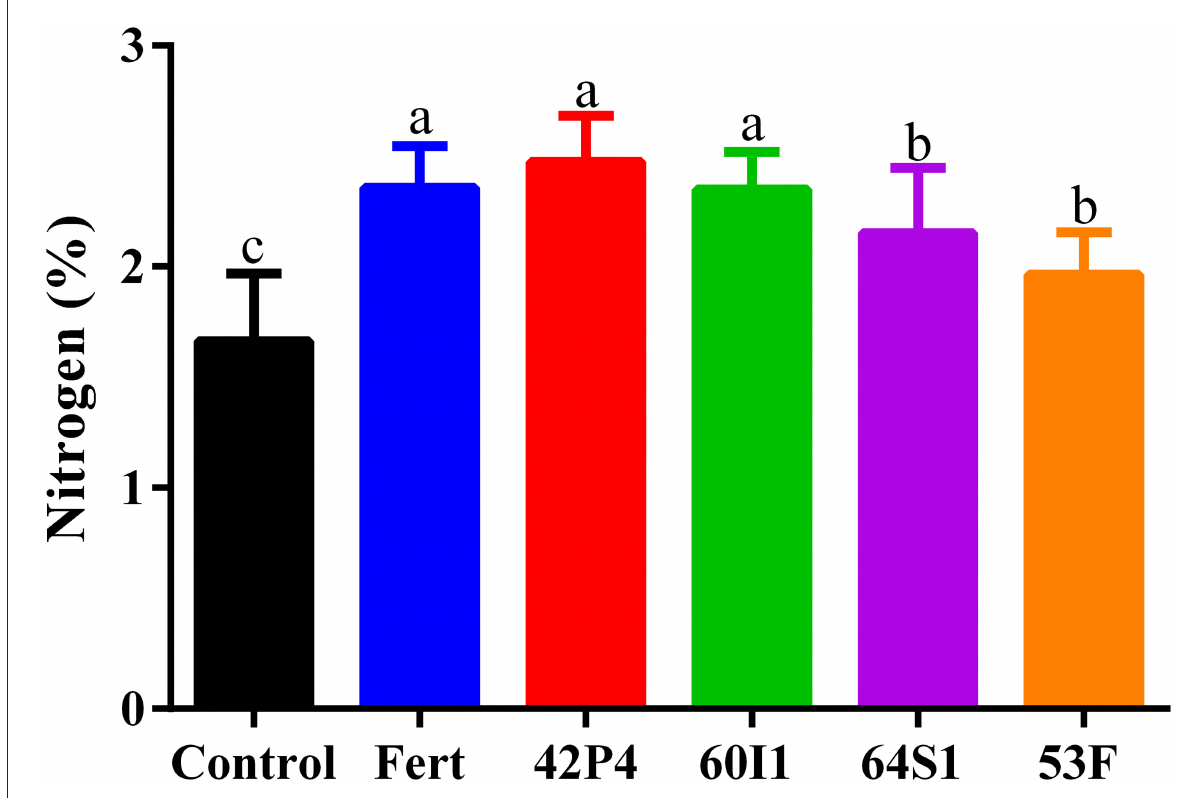
FIGURE3 Nitrogen content in leaves of pepper plants of 55 day-old after treatment with Fert: Fertilized; 42P4: Pseudomonas 42P4; 60I1: Cellulosimicrobium 60I1; 64S1: Enterobacter 64S1; 53F: Ochrobactrum 53F and Control (without bacteria). Data are presented as mean ± SEM of three independent biological replicates. Different letters indicate significant differences ( P < 0.0085) according to one-way ANOVA with Duncan’s multiple range